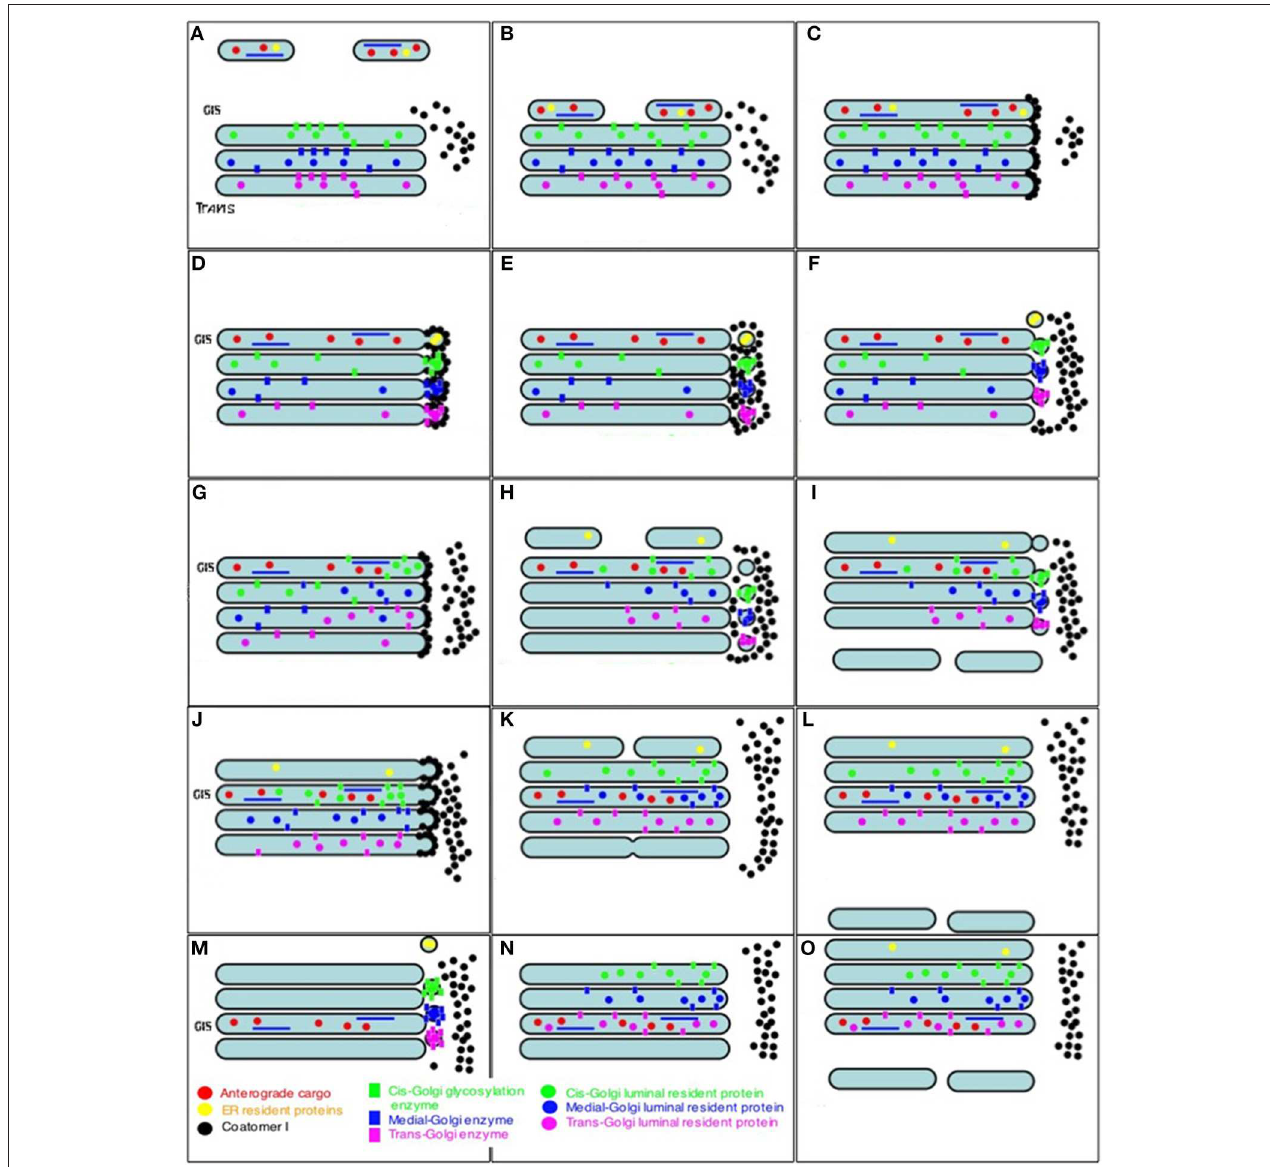
FIGURE 7 | Scheme of intra-Golgi transport according to the CMPM. The main postulate of this model is that during intra-Golgi transport, the amount of cargo inside the cisterna during its progression is not changed, and that COPI vesicles (COPI, black dots; Golgi-resident proteins, colored dots) should be concentrated in COPI vesicles. (A) Formation of ER-to-Golgi carriers (top). (B) Delivery of ER-to-Golgi carrier to the Golgi complex. (C) Fusion of ER-to-Golgi carriers and formation of the new cis- Golgi cisterna. (D) Formation of COPI-(black dots) coated buds on the Golgi cisternae. (E) Detachment of buds and their uncoating. (F) COPI-dependent vesicles fuse with the proximal Golgi cisternae. (G–I) A new round of cis- cisterna formation, COPI-dependent budding, formation of vesicles, and their uncoating and fusion. (I) Departure of the most-trans cisterna in the form of post-Golgi carriers. (J–N) Additional rounds of similar events. (O) After step-wise departure of the post-Golgi carriers, the cis- Golgi cisterna formed after re-initiation of IGT becomes the trans- cisterna.